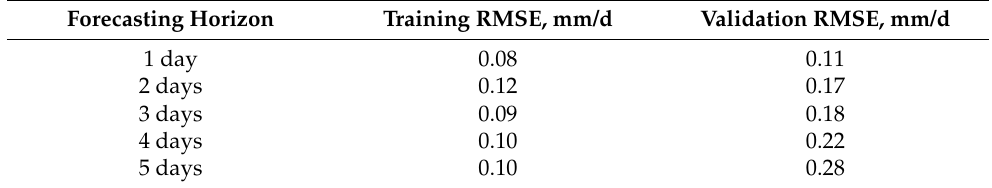
Table 11. Training and validation performances of the developed Bi-LSTM models at Gazipur station. Forecasting Horizon